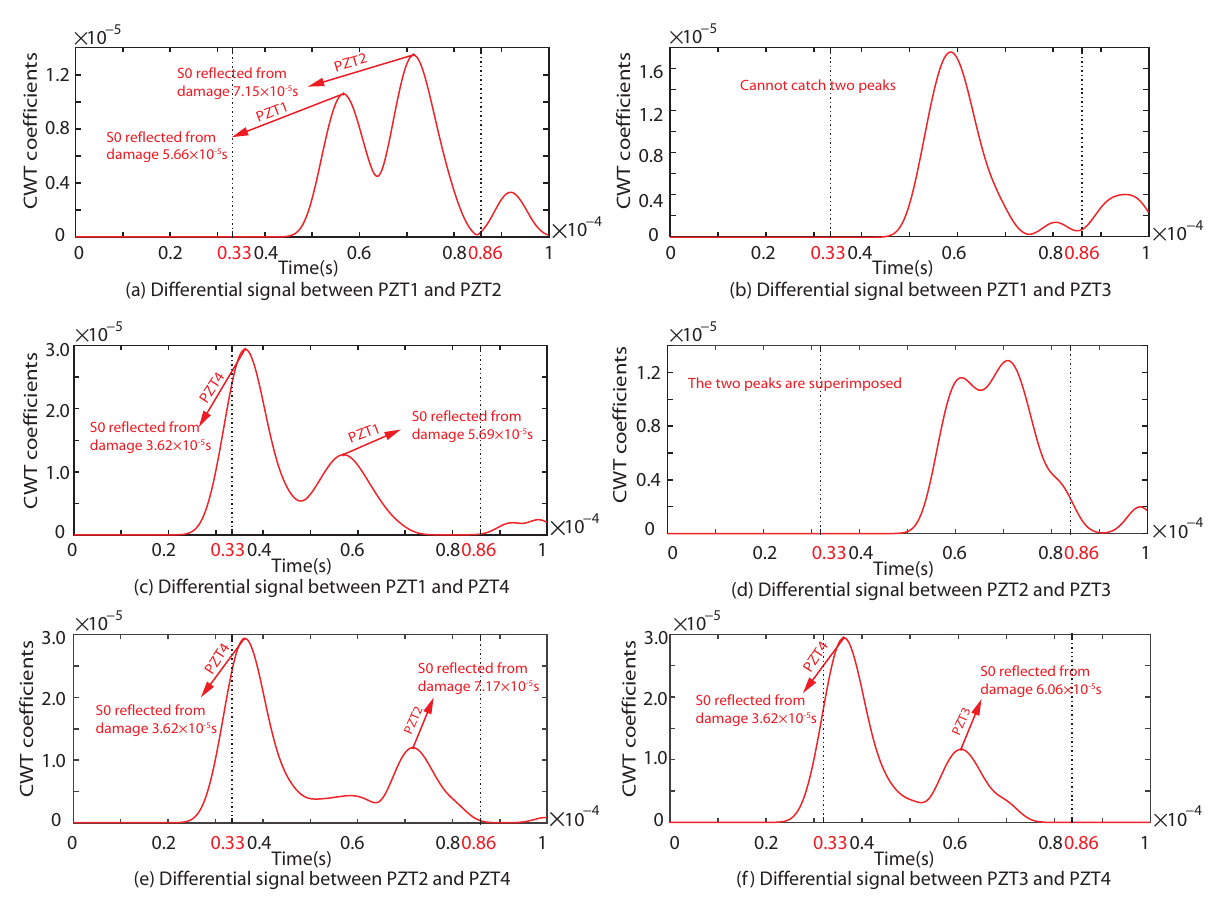
Figure 12. CWT coefficient of the difference signal of any two sensors under the simulation of Case I. According to the principles of the proposed NRDL method, the times of the two differ- ent signal peaks reflected by the damage can be obtained from Figure 12a,c,e,f, respectively. Each set of time is brought into Equation (4). Multiple groups of hyperbolas are calculated and drawn. The number of sensors corresponding to the time of the damage signal can be clearly marked in Figure 12, because the hole damage is prefabricated. However, the number of sensors in actual monitoring cannot be determined. The proposed method requires all signals to be different from one another. The calculation result of Equation (4) is not affected. It is only necessary to calibrate the serial numbers of the sensor in a certain order. As shown in Figure 12b, two peaks are not found in the effective time range. This group of signals is discarded. As shown in Figure 12d, although the time of two peaks can be found within the set time range, the times are too close. The signal superposition may occur and the real time cannot be determined. Therefore, this group of signals is also discarded according to principle (3). Multiple groups of hyperbolas can be obtained on the basis of complying with the above principles, as shown in Figure 13. As shown in Figure 13, seven intersections can be obtained. The coordinates of the intersections are shown in Table 2. Similarly, the results of the experiment are also processed. The CWT coefficients are shown in Figure